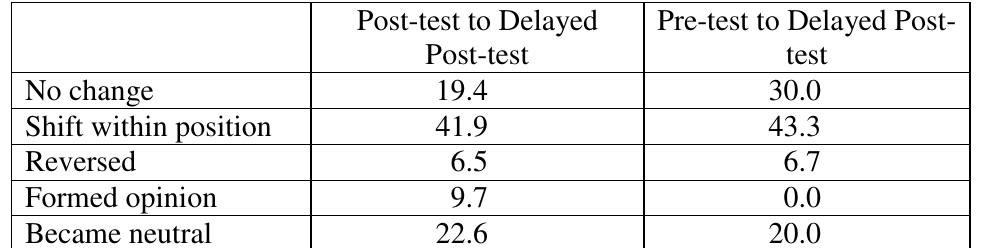
Table 6. Percentage of Participants Exhibiting Changes in Ratings of Fossil Fuels